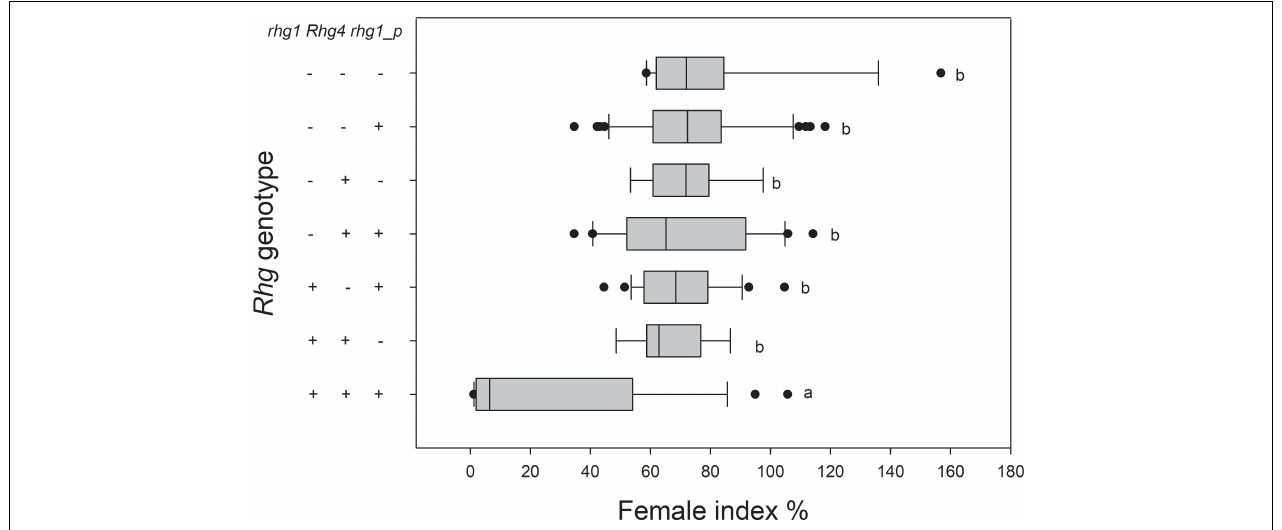
FIGURE 3 | Reaction of RILs to SCN4 based on pyramiding of the rhg1 , Rhg4 , and rhg1-paralog loci (+ = present; - = absent). There were significant differences between the Rhg genotypes at P < 0.05. rhg1-p represents